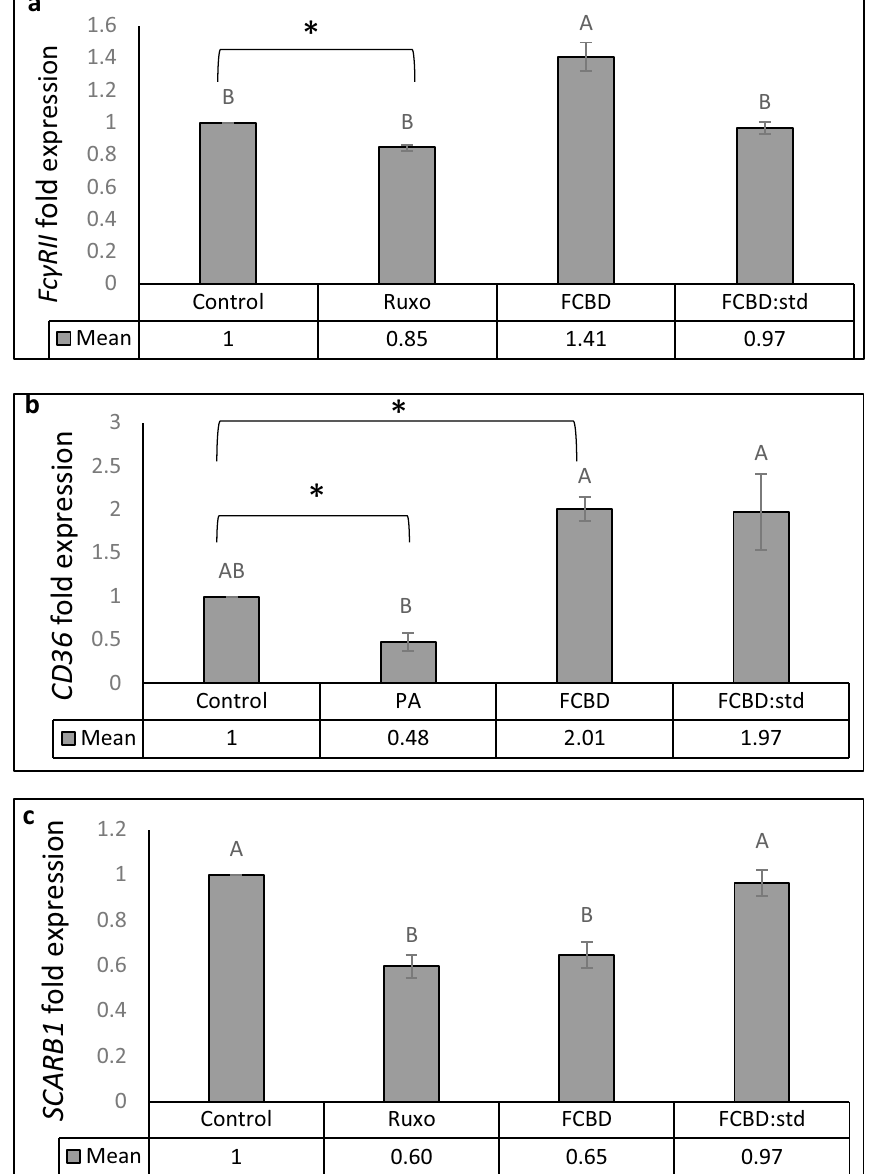
Figure 7. qPCR-based determination of the mRNA steady state level in the differentiated KG1 cell line. ( a ) FcγRII , ( b ) CD36 or ( c ) SCARB1 genes, after treatment with F CBD (FCBD) at 7 µg/mL, F CBD:std (FCBD:std) at 7 µg/mL, ruxolitinib (Ruxo) at 100 µg/mL or palmitic acid (PA) at 150 µM. In this experiment, controls (vehicle) for ( a ) and ( c ) were 0.7% v/v methanol + 2% v/v DMSO; for ( b ) 0.7% v/v methanol. Error bars indicate ± sem (n = 3). Bars labeled with different letters are significantly different from all combinations of pairs according to the Tukey–Kramer HSD test ( P ≤ 0.05). *Indicates significantly different mean from the control based on the Student T-test ( P ≤